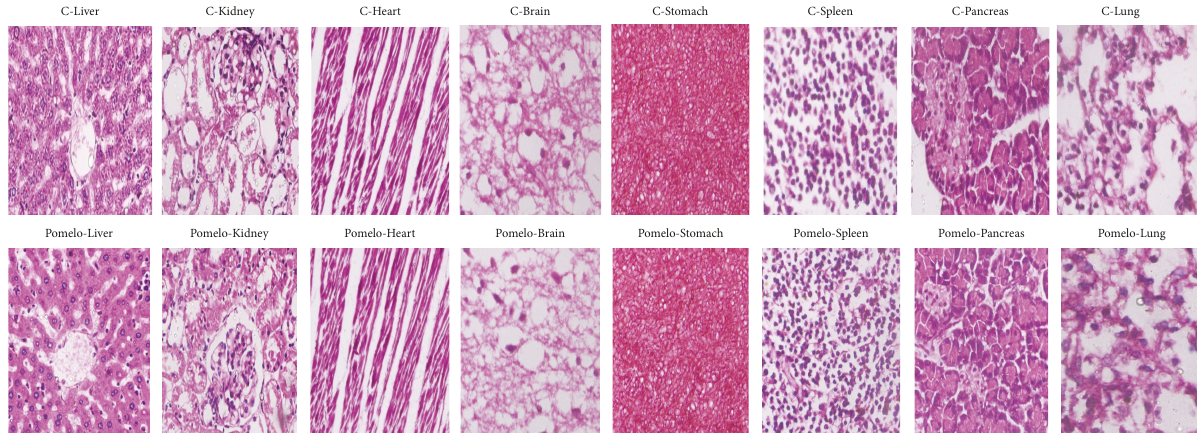
Figure 6: Histopathological photomicrographs of control and treatment group (1000mg/kg) (6100 X magnification, scale bar: 20 𝜇 m). No morphological and pathological changes were observed between the control and pomelo extract administered groups, where C=control. Figure 6 is reproduced from Sudip Paul et al. (2017) [under theCreative Commons Attribution License/public